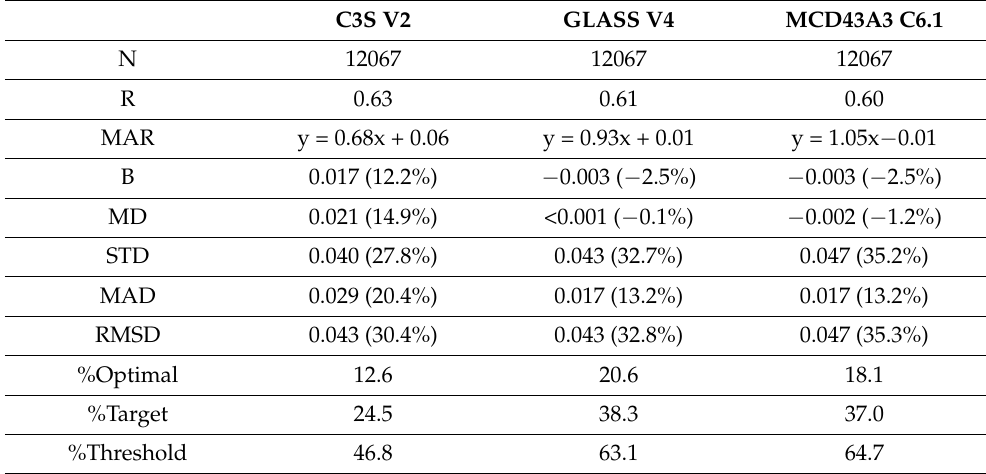
Table 12. Summary of the main statistics for the direct validation of C3S V2, GLASS V4, and MCD43A3 C6.1 satellite blue-sky albedo products vs. blue-sky albedo ground values from the REALS dataset in the 2000–2019 period. All pixels were taken into account.